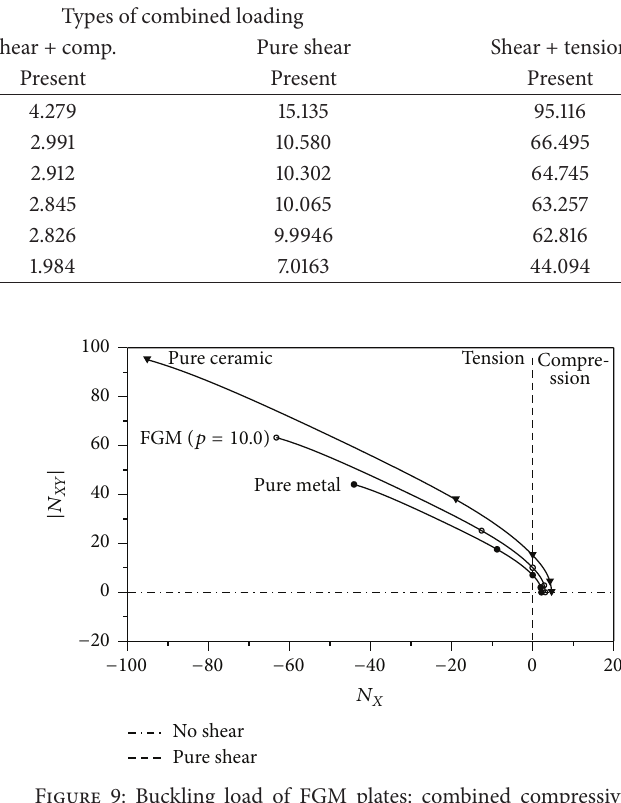
Figure 8: Effect of power law index on the nondimensional natural frequency of CCFF FGM plate with variation of side-to-thickness ratio.